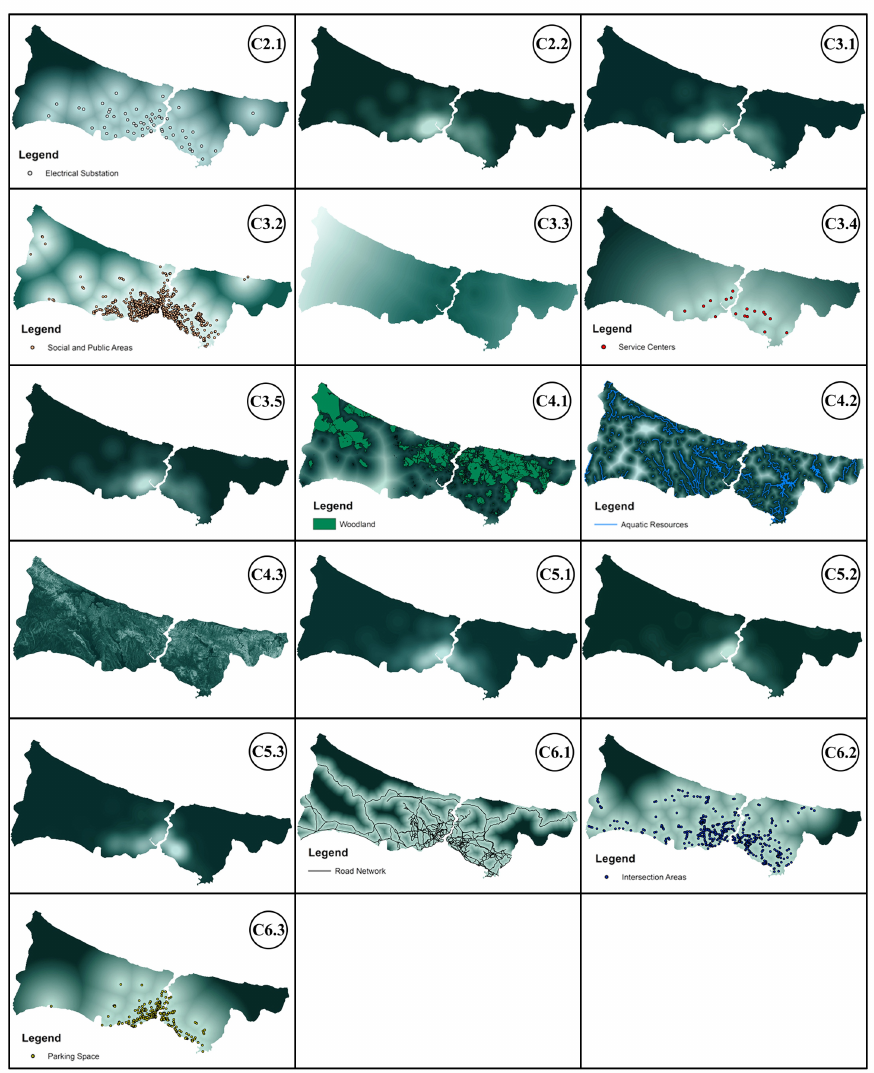
Figure 5. Normalisation maps of 16 evaluation criteria. In normalisation maps of C3.3 and C4.3 criteria, dark green areas represent suitable areas, and light green areas in all other normalisation maps indicate suitable areas. A reclassification analysis, which is vital in determining the most suitable areas, is before the overlapping